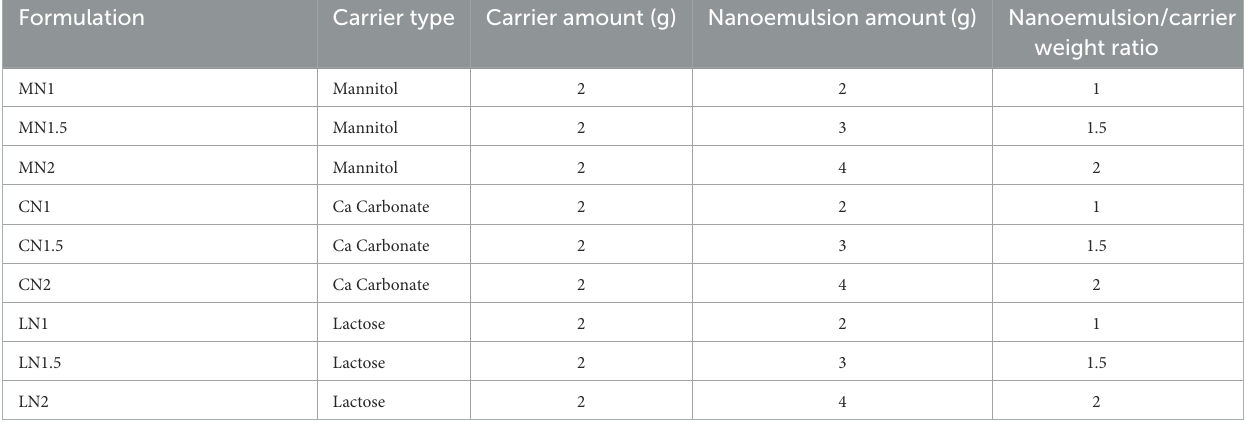
TABLE 2 Nanoemulsions/carrier powders obtained using a controlled wetting/drying process.